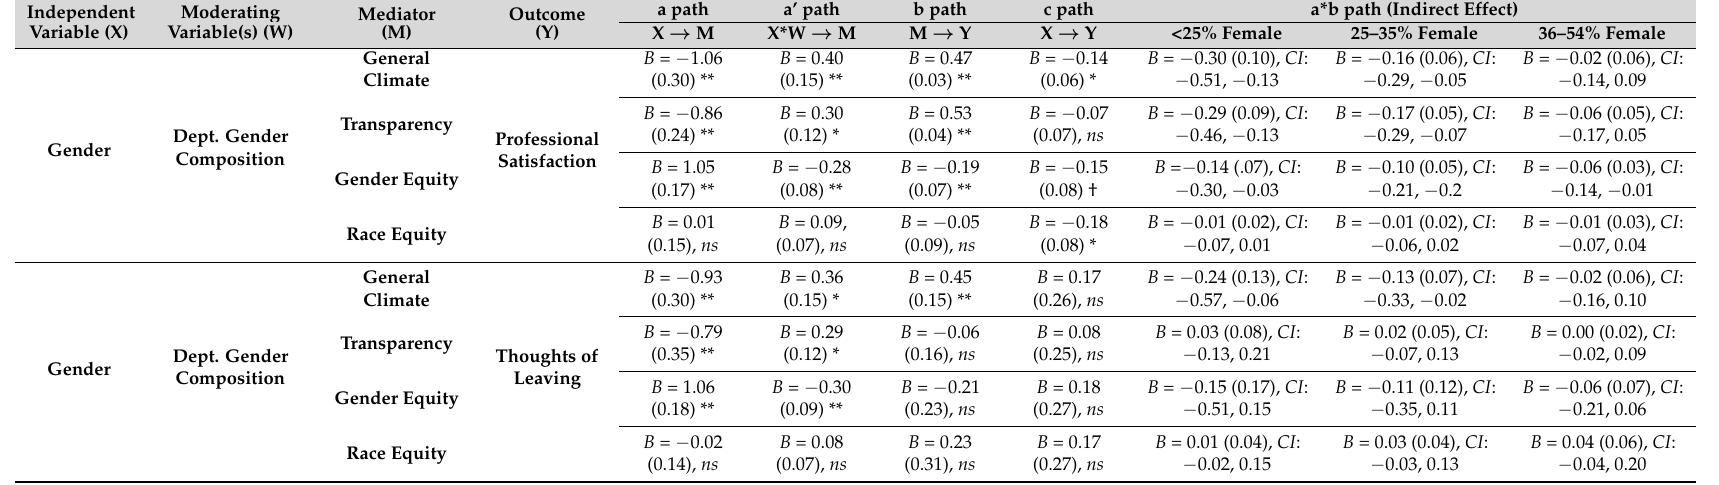
Table 4. Moderated mediation: Gender differences in perceived climate and professional satisfaction, as moderated by department gender